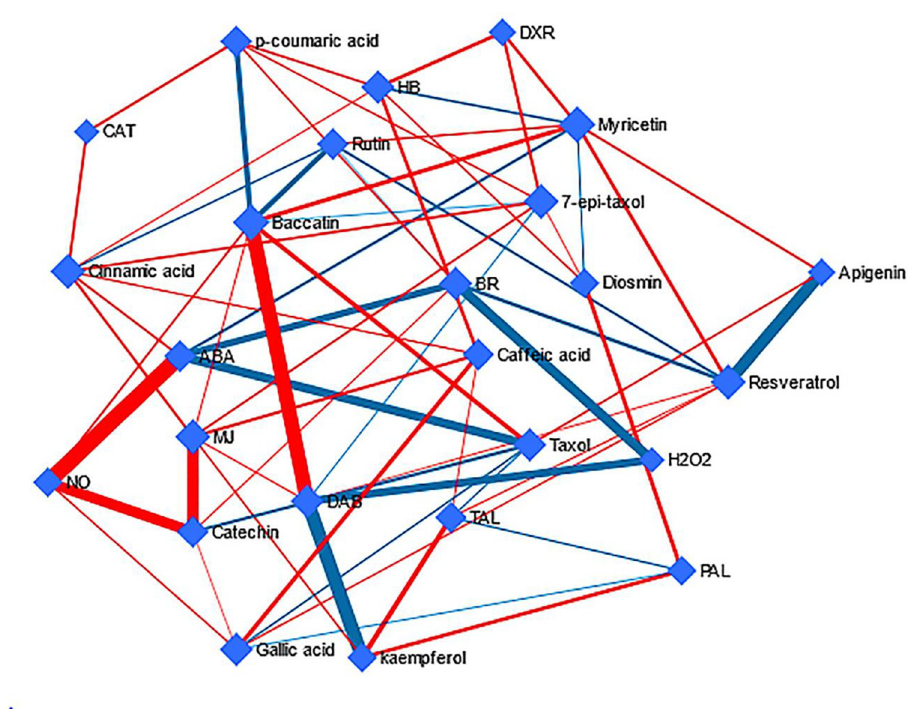
Fig 6. Network building between taxanes, phenolic acids and flavonoids based on DSPC analysis. Nodes demonstrate reconstructing correlation-based networks of compounds and the edge thickness is proportional to the strength of the shown